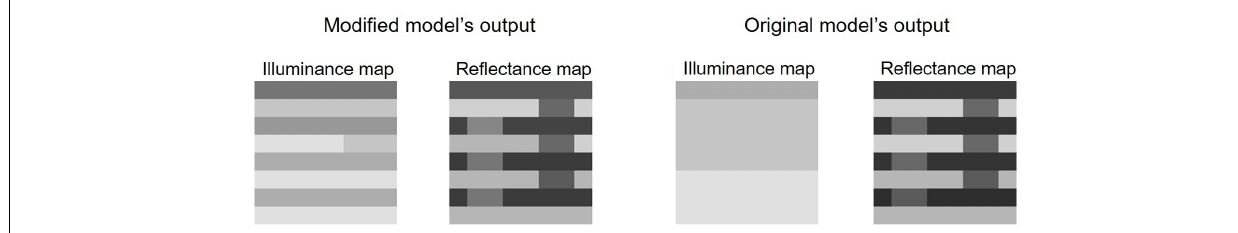
FIGURE 3 | Outputs for the predictions of White’s effect by the two models.